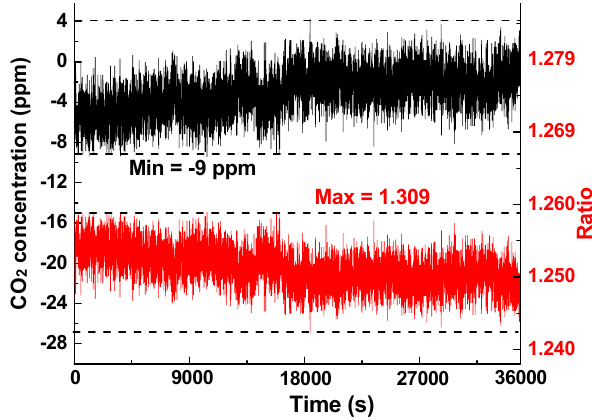
Figure 7. ( a ) Long-term measurement results on a CO 2 standard sample with a concentration level of 500 ppm; ( b ) Long-term measurement results on a CO 2 standard sample with a concentration level of 2000 ppm.